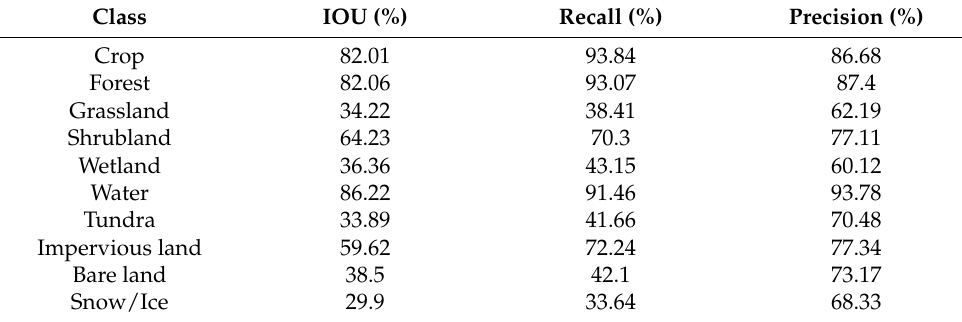
Table 3. 10-categories accuracy statistics *.